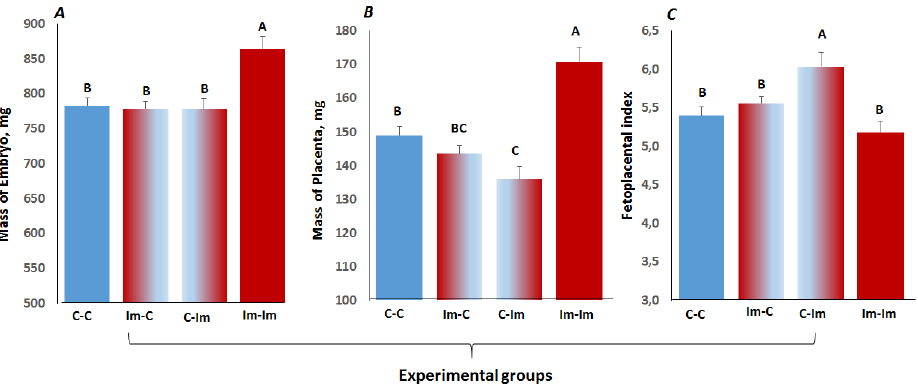
Figure 4. Embryo mass ( A ), mass of placenta ( B ), and fetoplacental index ( C ) on day 16 of pregnancy in surrogate mothers of the studied experimental groups. The letters above indicate significantly different mean values (LSD test, p < 0.05).